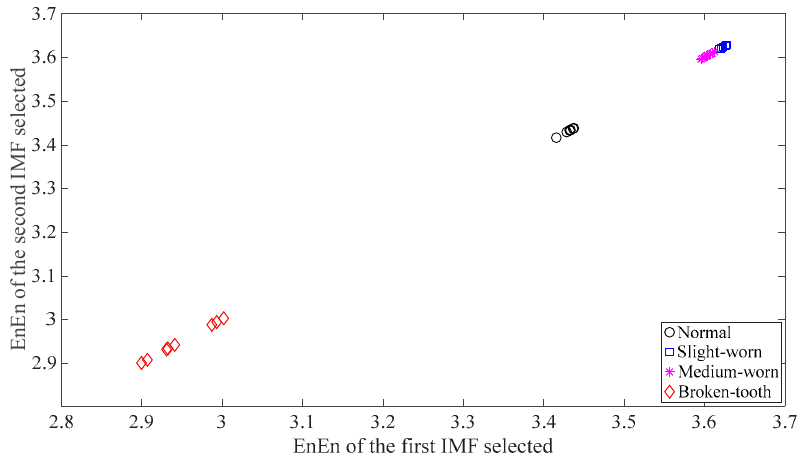
Figure 9. Two-dimensional EnEn of the two IMFs most correlated with the original data for each of the four types of gear condition. In this case, the first two IMFs are selected for use.